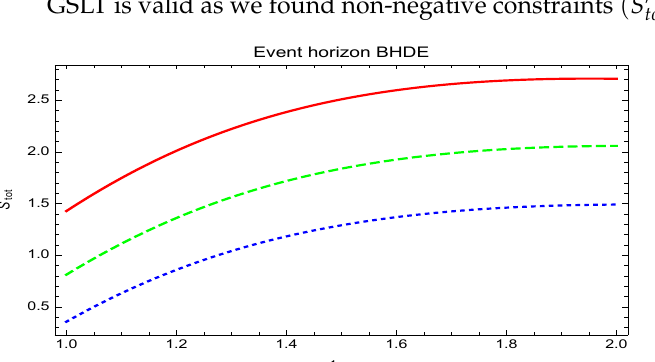
+ z for interacting BHDE model with Figure 14. The evolution of S (cid:48) tot versus redshift parameter 1 event horizon under GDP braneworld